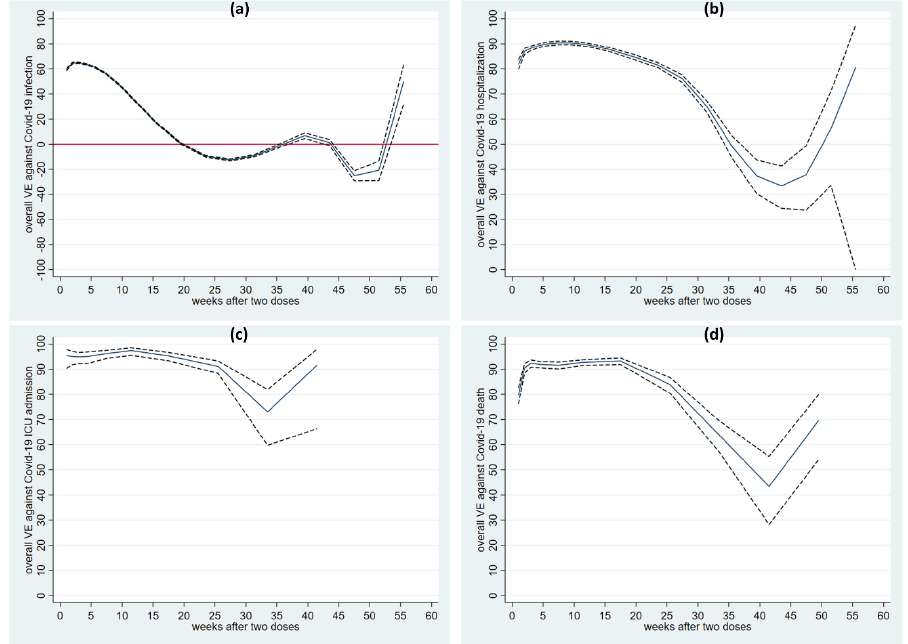
Figure 2. Unrestricted cubic splines of vaccine effectiveness against COVID-19 infection (panel ( a )), hospitalization ( b ), severe outcomes [ICU admission ( c ), and death ( d )] after two doses. Legend: VE denotes vaccine effectiveness. The area within the dotted line indicates 95% confidence intervals. Note that the y-axis scales are different for infection ( a ) and the others. The red line in ( a ) indicates VE = 0.